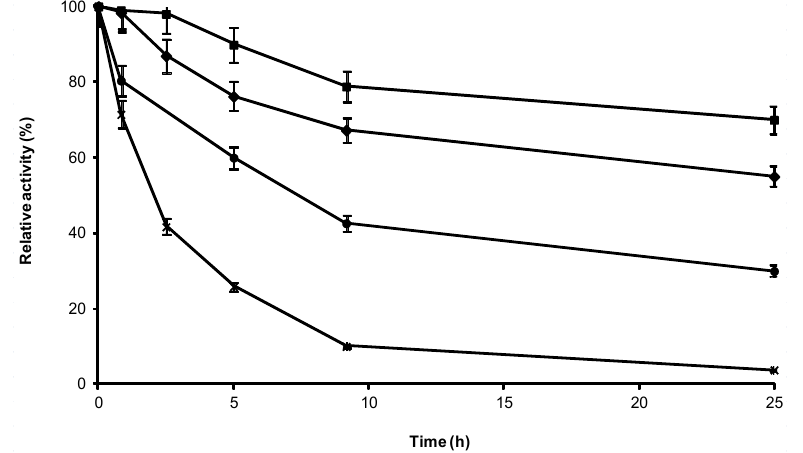
Figure 6. Inactivation profile of different CRL immobilized preparations in the presence of co-solvent. Experiments were carried out at 25 °C, pH 5 and 30% ( v / v ) acetonitrile. Free CRL (×), Ald ‐ EDA ‐ CRL (rhombus), Ald ‐ CRL (squares), Ald ‐ Lew105 ‐ CRL (circles).